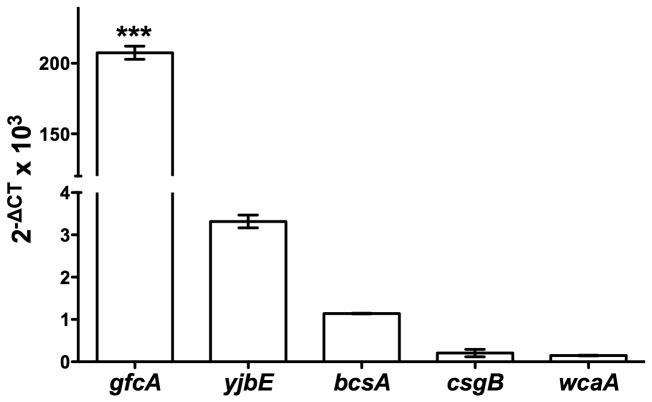
Expression of surface structures by EPEC.Transcription of the indicated genes was quantified by qPCR. Data shown (2-ΔCT x 103) are normalized against transcription of the 16S RNA gene. Results are expressed as means ± SEs of triplicate samples. Asterisks indicate statistical significance; ***, P <0.001 by one-way ANOVA and Bonferroni’s multiple comparison post
hoc test.